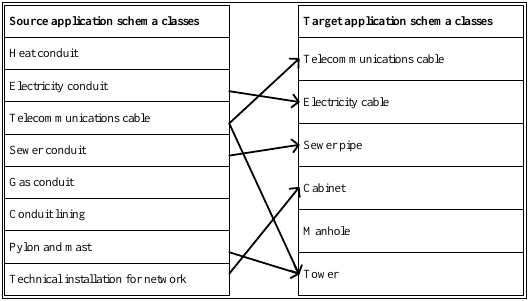
Figure 5. Simple reclassification prepared by expert